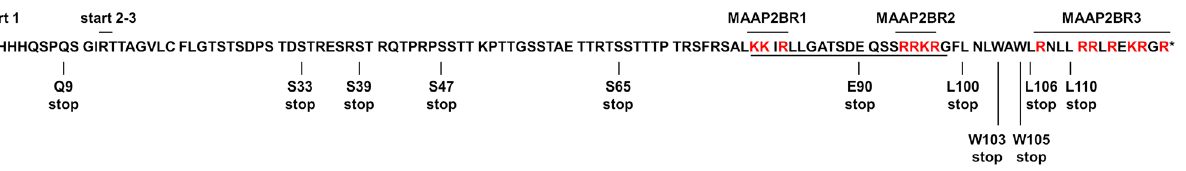
Figure 1. MAAP sequence. MAAP is encoded in the wt-AAV2 genome (GenBank Sequence ID: AF043303.1) at nucleotides 2282-2641. The ORF is located on the same DNA region encoding the VP1/2 unique domains. VP1/2 are encoded on reading frame + 1 and MAAP on reading frame + 2. MAAP translation initiates at a CTG codon (start 1), encoding a leucine which corresponds in position to VP1 proline in position 27. The next potential start codons are MAAP-T13 (ACG) and MAAP-R14 (AGG) (start 2-3). In red are the three basic-amino-acid-rich clusters MAAP2BR1, MAAP2BR2 and MAAP2BR3. Underlined is the sequence of the peptide used to generate MAAP polyclonal antiserum. All studied amino acid substitutions are shown below the